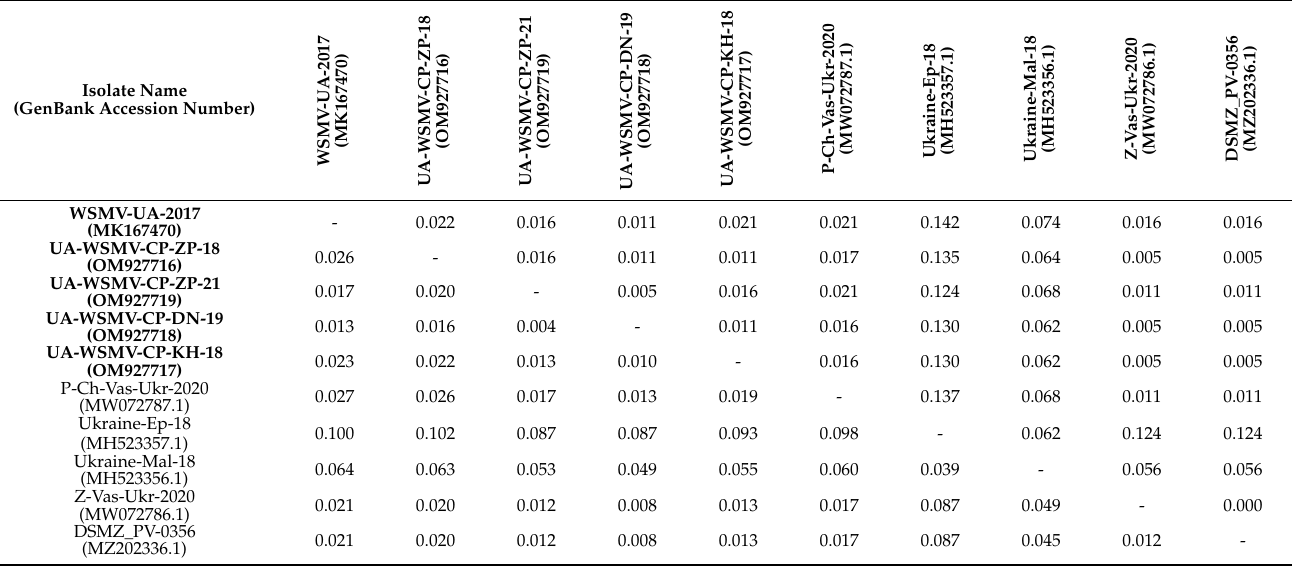
Table 4. Pairwise distances of nucleotide (below diagonal) and amino acid (above diagonal) partial sequences of Ukrainian isolates of WSMV. WSMV isolates described in this study are shown in